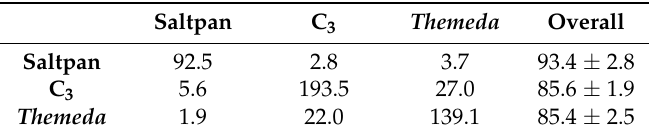
Table A4. Mean confusion matrix for WorldView-2 three-class classification results. Confusion values are given as a count value, and overall accuracies as a percentage with standard deviation.